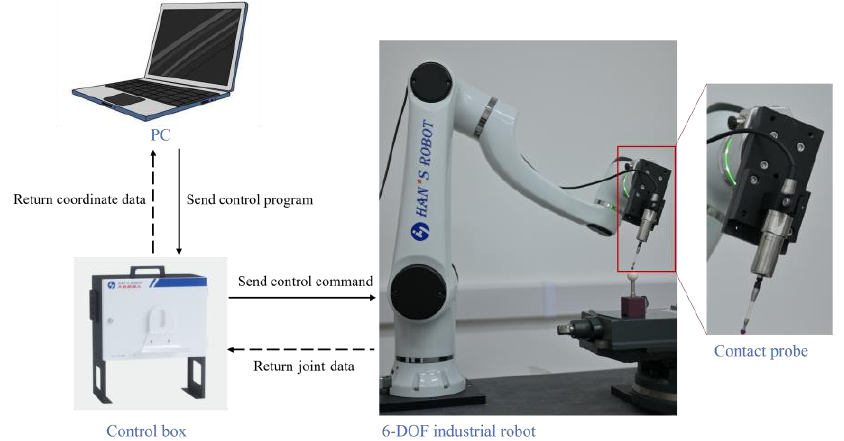
Figure 1. Measurement system.